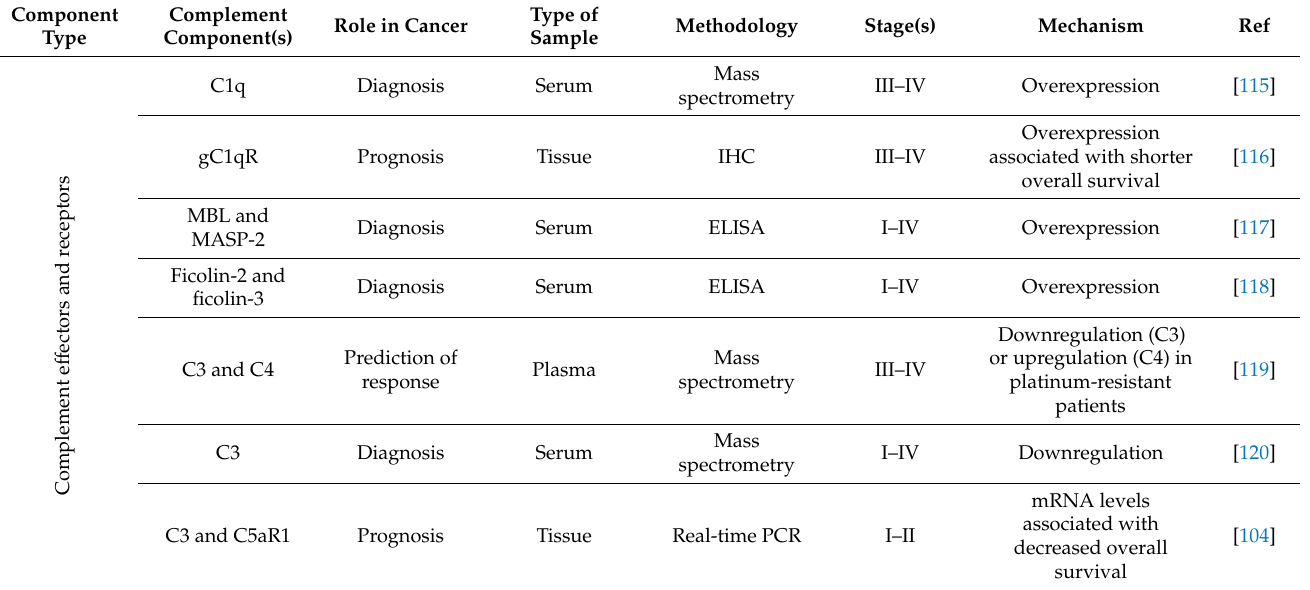
Table 2. Summary of the studies performed with clinical samples reporting the potential clinical use of the determination of complement